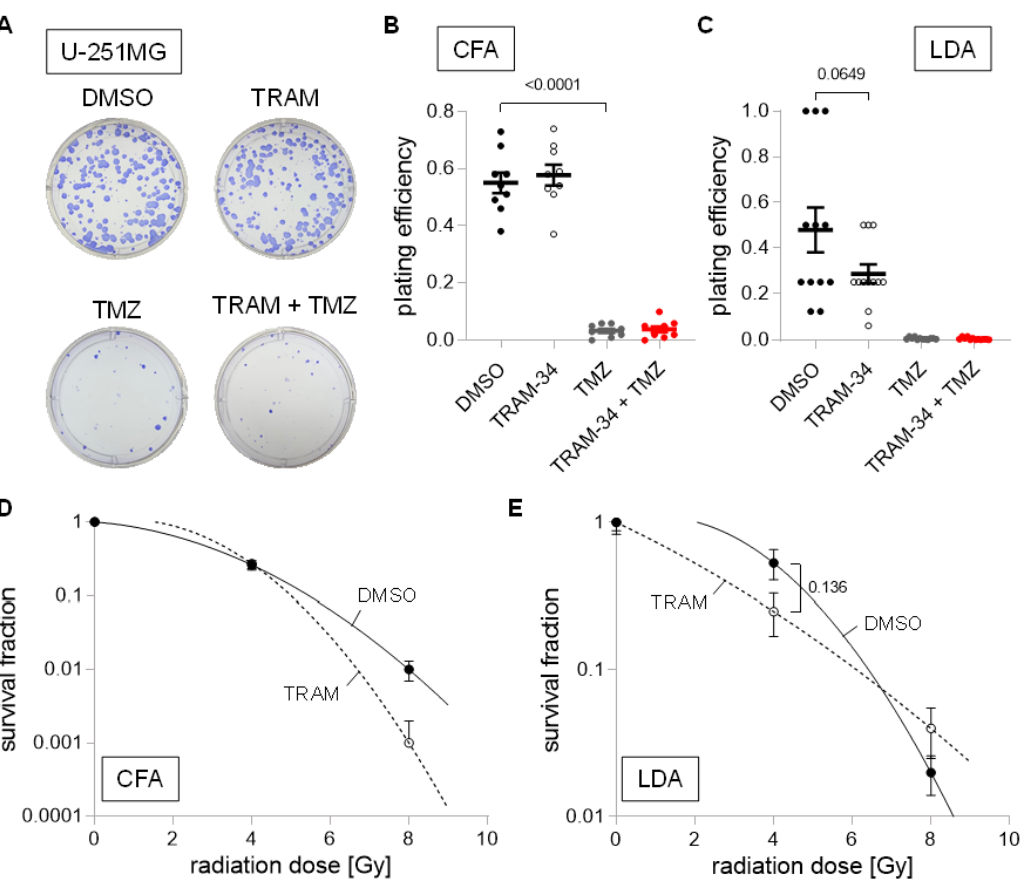
Figure 9. Cell culture condition-dependent effects of K Ca 3.1 blockade on sensitivity to irradiation and temozolomide in U-251MG cells. ( A – C ). Representative images of colony formation ( A ) and plating efficiencies ( B ) of DMEM-grown or ( C ) NSC-grown cells after irradiation with 0 Gy and co-treatment with vehicle (DMSO, closed black circles), TRAM-34 (5 µ M, open circles), temozolomide (TMZ, 30 µ M, closed grey circles), or TRAM-34 (5 µ M) together with temozolomide (TMZ, 30 µ M, closed red circles). ( D , E ). Survival fractions of irradiated (0–8 Gy) cells co-treated with vehicle (DMSO, closed black circles) or TRAM-34 (5 µ M, open circles) as determined by colony formation assay for DMEM-grown ( D ) and limited dilution assay for NSC-grown U-251MG cells ( E ). Data are individual values in ( B , C ) and mean ± standard error in ( B – E ) of three experimental units with three to four observational units each. Survival fraction curves were fitted according to the linear quadratic model and given as follows: DMSO, solid black line; TRAM-34, dashed line. Numbers in ( B , C , E ) indicate error probabilities ( p values) as calculated with one-way ANOVA and Tukey multiple comparison